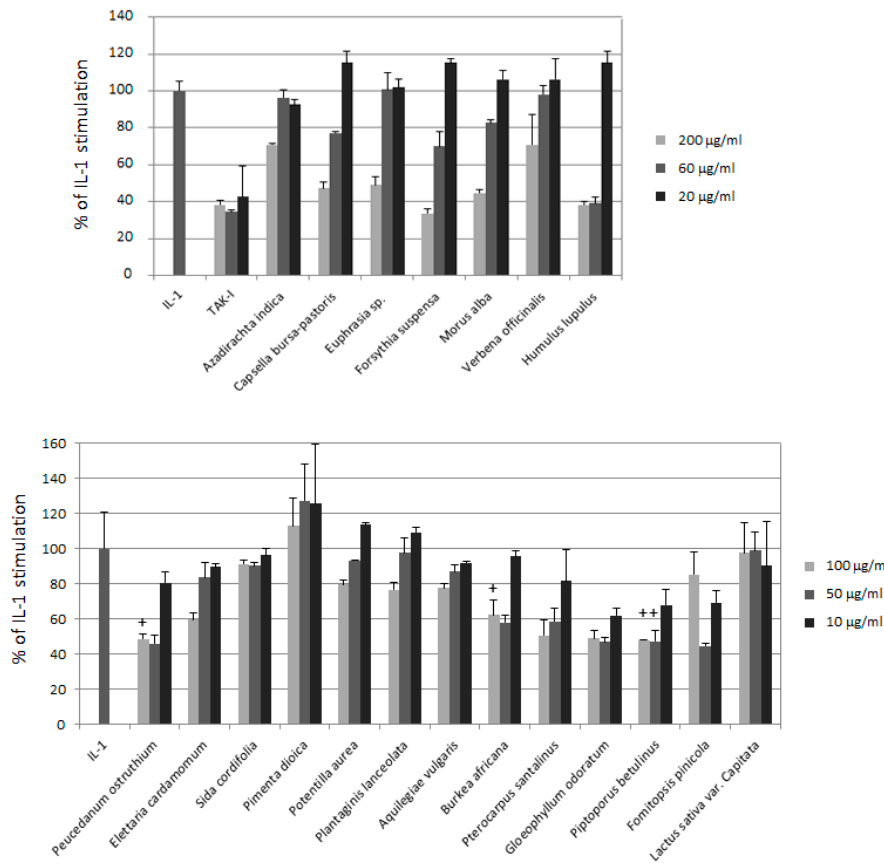
Figure 1. Inhibition of E-selectin expression by herbal and fungal extracts. Experiments were performed in two separate sets (upper and lower panel). HUVECs were pre-incubated for 30 min with di ff erent concentrations of extracts as indicated, stimulated with 5 ng / mL IL-1 for 4 h and analyzed by cell ELISA. The TAK inhibitor (TAK-I) was used as positive control at 10, 5, 2.5 µ M. Relative levels of E-selectin as compared to IL-1 alone are shown. Samples marked with an “ + ” indicates apparent cytotoxicity as judged by morphological